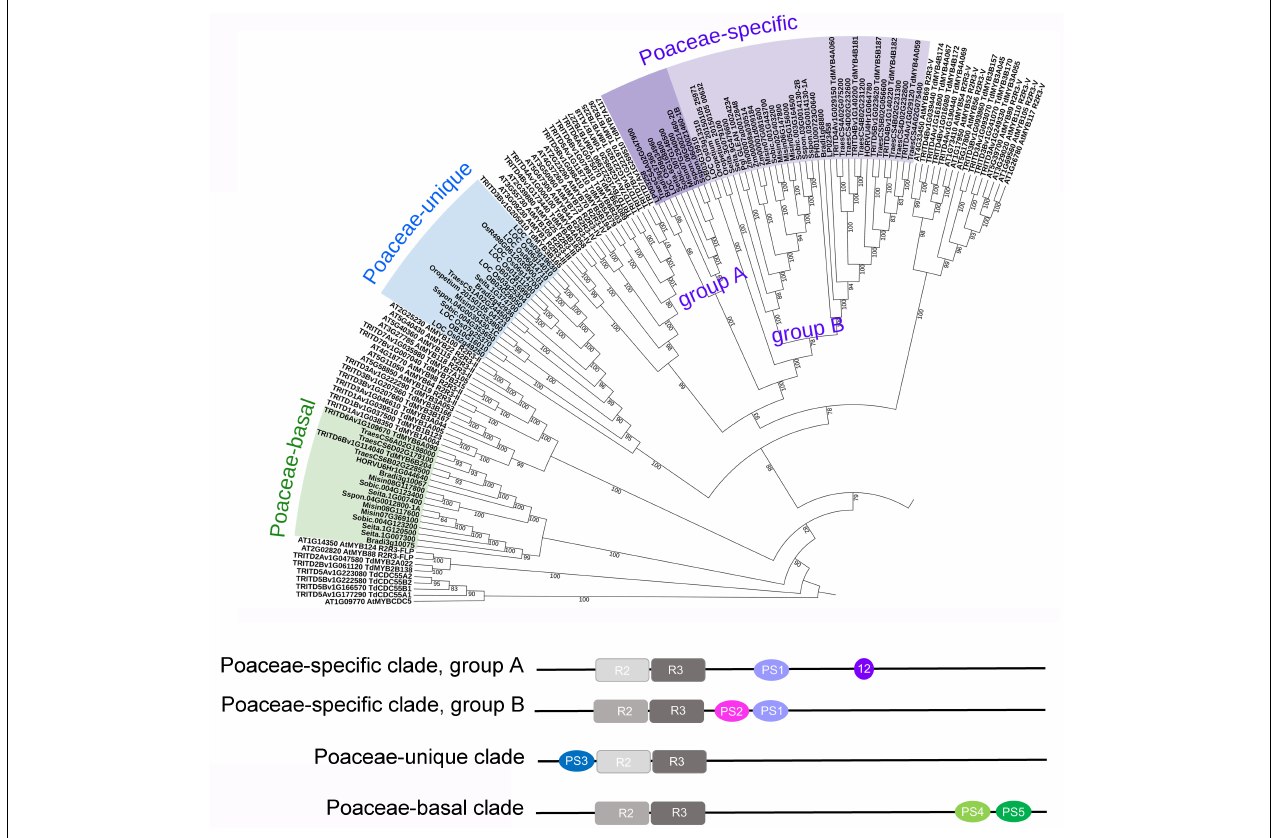
FIGURE 4 | Phylogenetic relationships of Poaceae peculiar sequences with other R2R3-MYBs, and their motifs. Upper panel: a portion of the phylogenetic tree including Arabidopsis thaliana (127 AtMYBs), durum wheat (237 TRITD-TdMYBs), and R2R3-MYBs exclusive of the Poaceae family (77 sequences), clustering in three clades, namely Poaceae-specific (groups A and B), Poaceae-unique, and Poaceae-basal clades. Lower panel: graphic representation of the position of R2R3 and Poaceae peculiar motifs (PS1 to PS5); in Poaceae-specific clade group A, 12 refers to motif 12-Jiang. Species name abbreviations: Bradi: Brachypodium distachyon ; Pgl_GLEAN: Cenchrus americanus ; HORVU: Hordeum vulgare ; LP: Lolium perenne ; Misin: Miscanthus sinensis ; Oropetium: Oropetium thomaeum ; OB: Oryza brachyantha ; LOC_Os: Oryza sativa subsp. japonica ; Os: Oryza sativa subsp. indica ; PH: Phyllostachys edulis ; Sspon: Saccharum spontaneum ; Seita: